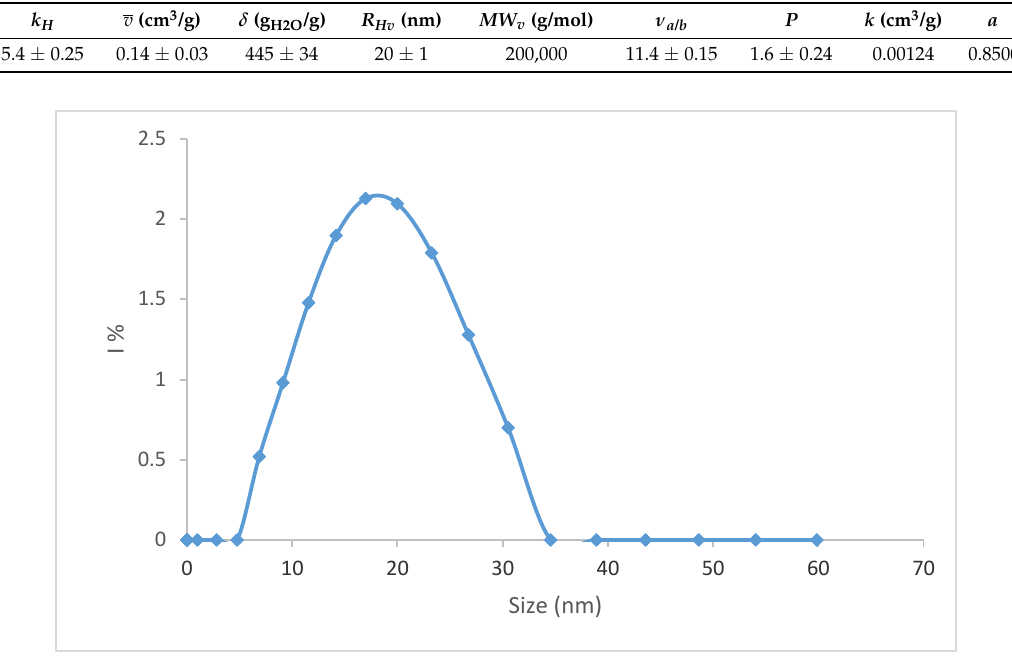
Figure 6. Plot obtained in the DLS analysis (I% vs. Size), media is R HDLS .